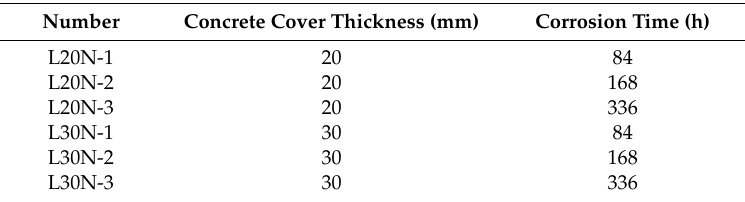
Table 4. Parameters of the specimens.